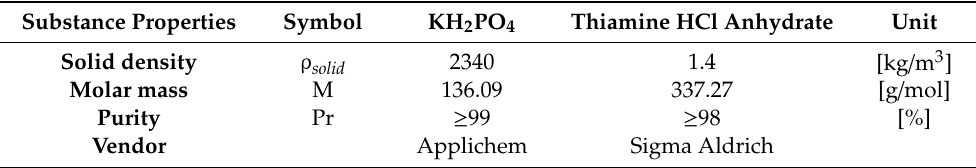
Table 1. Properties of the utilized substances KH 2 PO 4 and thiamin hydrochloride. Substance Properties